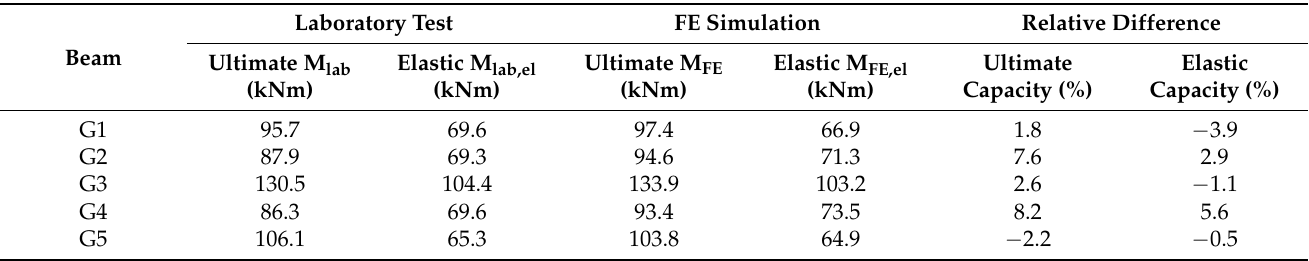
Table 3. Comparison of the load-carrying capacities obtained from laboratory tests and FEM simulations.